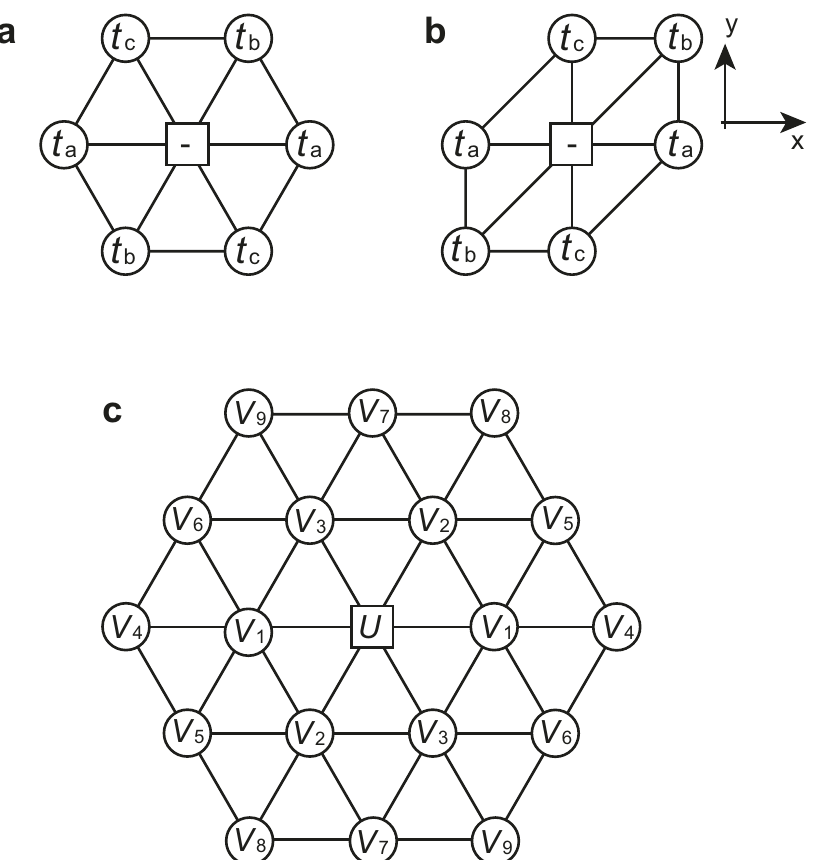
Fig. 6 De fi nitions of ab initio parameters and the form of the lattice for X [Pd(dmit) 2 ] 2 . a De fi nitions of hopping amplitudes. t a > t b > t c is satis fi ed in all the single-band effective Hamiltonians we studied. The square denotes the reference site and t n ( n = a , b , and c ) on circles denotes the hopping amplitudes from the reference site. The values are listed in Table 1. b De fi nitions of deformed triangular lattice and x − y axes. c : De fi nitions of screened Coulomb interactions on the lattice corresponding to non-deformed lattice in ( a ). U and V n ( n = 1 – 9) on circles denote the screened Coulomb interactions from the reference site (square in the center). In the actual calculation, the same deformed structure as b is used. The values are listed in Table 1. We take into account all the transfers and interactions illustrated